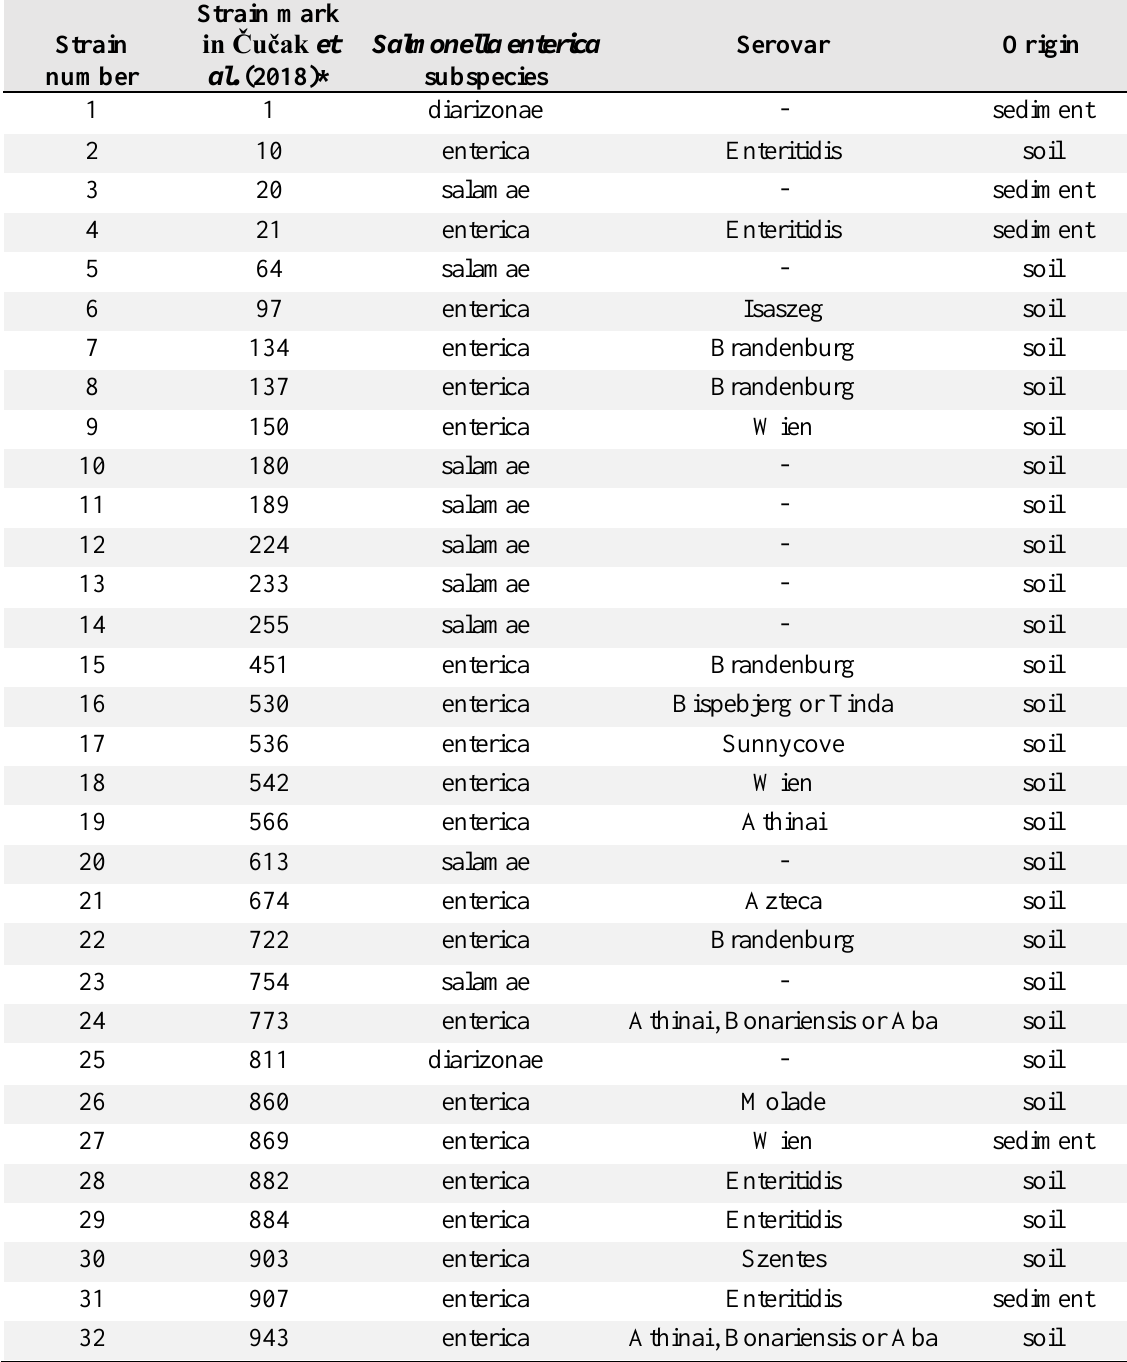
Table 2. Environmental Salmonella enterica strains on which antimicrobial activity of Allium cepa dry scale decoction and extracts was tested. Strains were isolated and characterized in detail in the previous study (Č UČAK et al .,